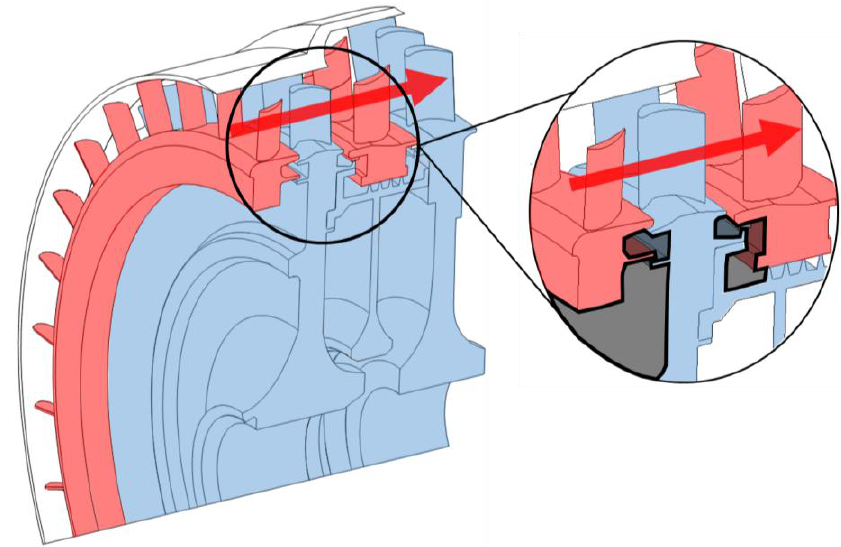
Figure 1. A typical gas turbine stage; rim-seals, highlighted in black, are shown inset (red highlight: stationary discs; blue highlight: rotating discs).